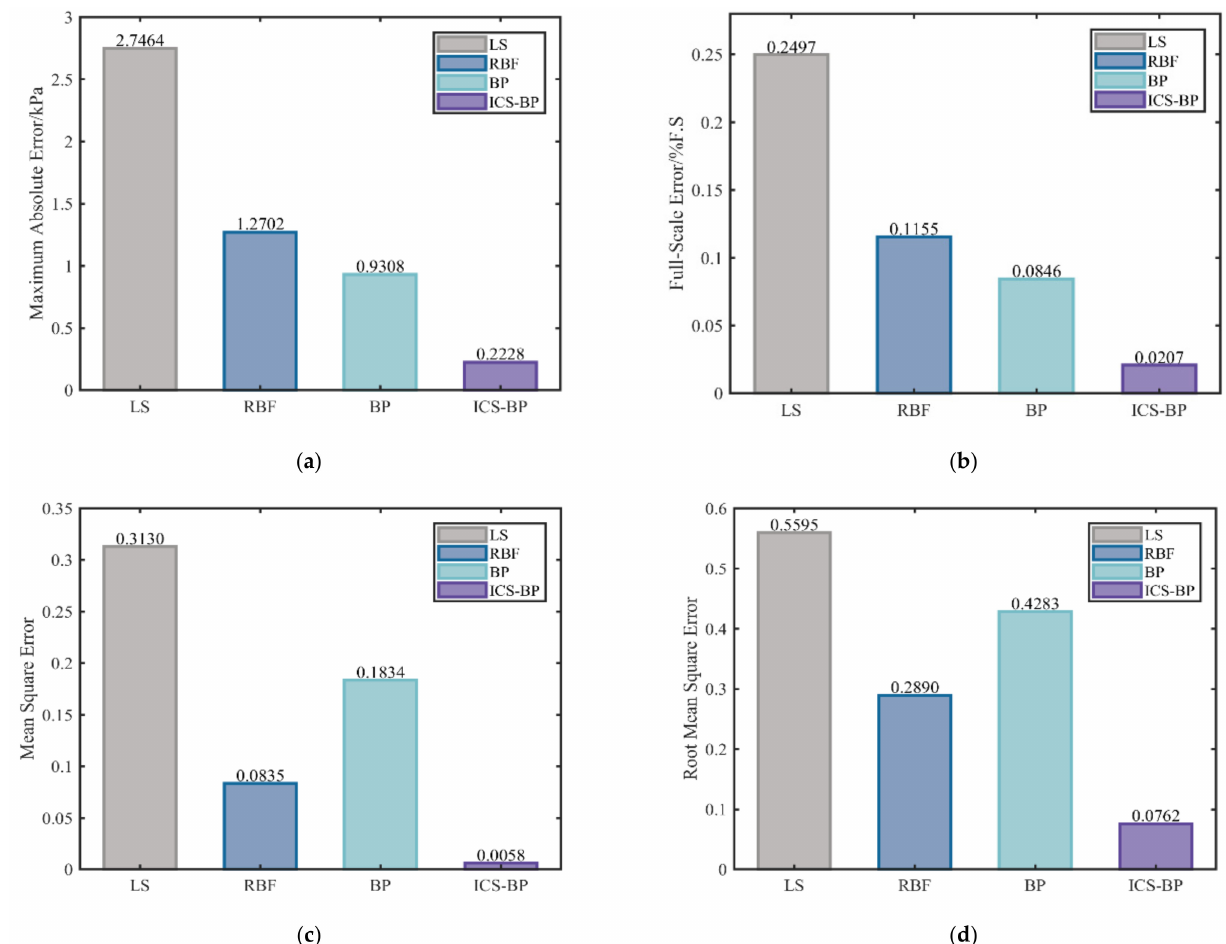
Figure 8. Experimental results: ( a ) maximum absolute error, ( b ) full-scale error, ( c ) mean square error, ( d ) root mean square